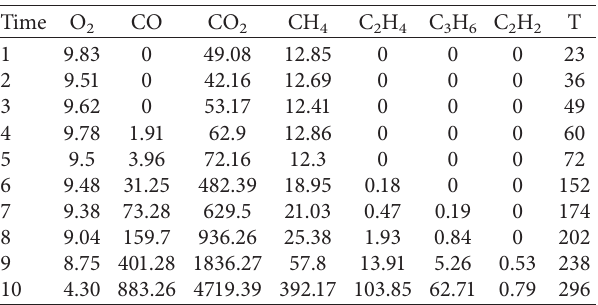
Figure 1: The trend of gas concentration change. Table 1: Sample of original